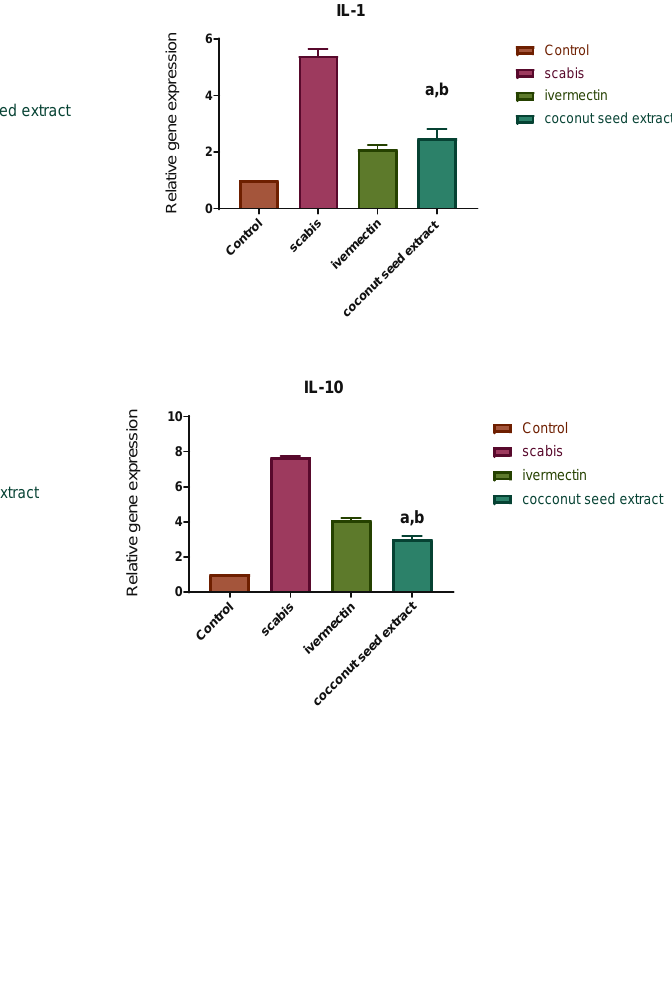
Control scabis ivermectin cocconut seed extract a,b Figure 7. Relative gene expression in skin tissue of different animal groups using qRT-PCR. After normalization to GAPDH, the data reflect a fold in expression compared with the normal control group. The bars represent mean ± SD. To determine if there is a significant difference between groups, a one-way ANOVA test was performed with (a) p < 0.05 compared with the normal control group and (b) p < 0.05 compared with the market-drug-induced group.